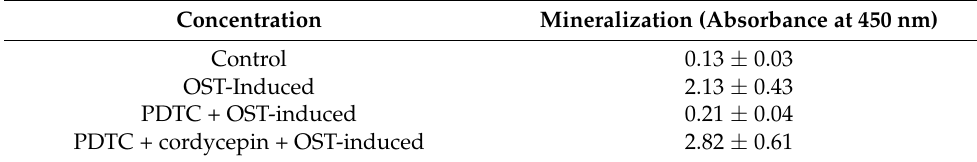
Figure 2. Adipogenic differentiation of DPSCs and quantitative RT-qPCR study of gene expression. ( A – C ) Adipogenic differentiation was induced in DPSCs with and without cordycepin administration, and oil red O was used for functional staining. Scale bar = 100 μm, ( D – G ) Comparative gene expression study of genes involved in adipogenesis PPARγ, FABP4, LPL, C/EBPα in with and without cordycepin treated adipogenesis induced DPSCs. ns not significant, ** p < 0.01. ADIP- induced: adipogenic induction, Cpn: cordycepin, PPARγ: peroxisome proliferator-activated receptor-gamma, FABP4: fatty acid-binding protein 4, LPL: lipoprotein lipase, C/EBPα: CCAAT/enhancer-binding protein alpha . Table 6. Quantification of mineralization alizarin red staining—day